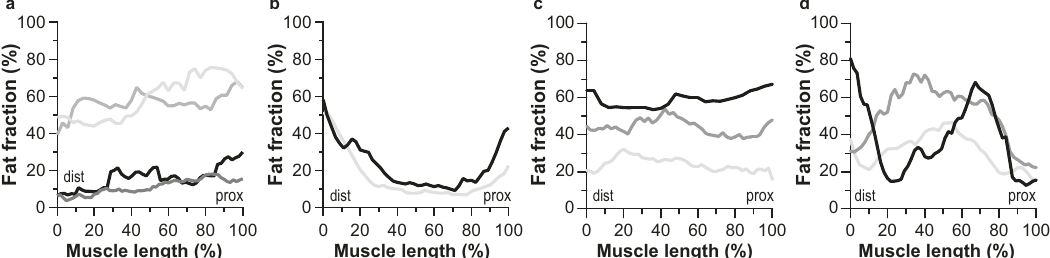
Fig. 6 Typical examples of muscles in facioscapulohumeral muscular dystrophy (FSHD) patients not showing a decreasing distal-to-proximal fat in fi ltration pro fi le. a One vastus medialis (light grey), one rectus femoris (medium grey), one peroneus (dark grey), and one extensor digitorum (black) muscles showing a reversed gradient, with a higher fat fraction proximally. b Tibialis anterior muscles showing a higher fat fraction distally and proximally. c Muscles with a homogenously elevated fat fraction along the muscle: peroneus (light grey), extensor digitorum (dark grey), and biceps femoris short head (black). d Muscles with fat in fi ltration in the middle of the muscle: gracilis (light grey), vastus medialis (dark grey), and rectus femoris